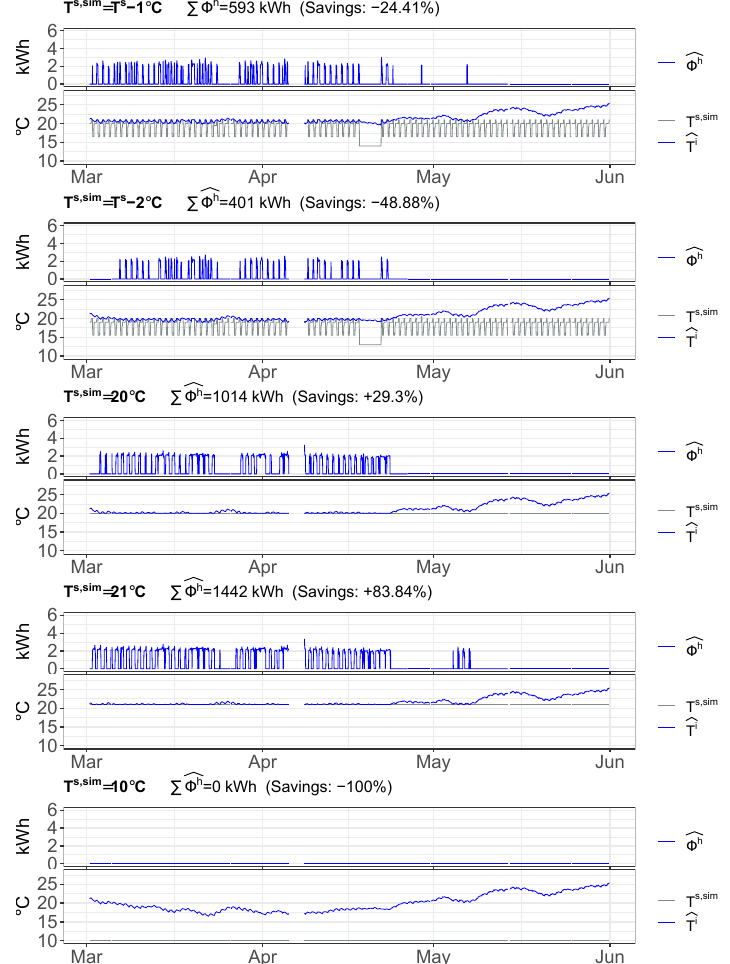
Figure 14. Energy potential savings applying different set point temperatures scenarios ( T s , sim ) over one